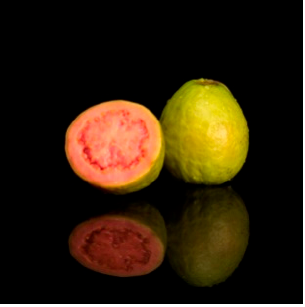
Figure 4. Experimental sample of red guava.